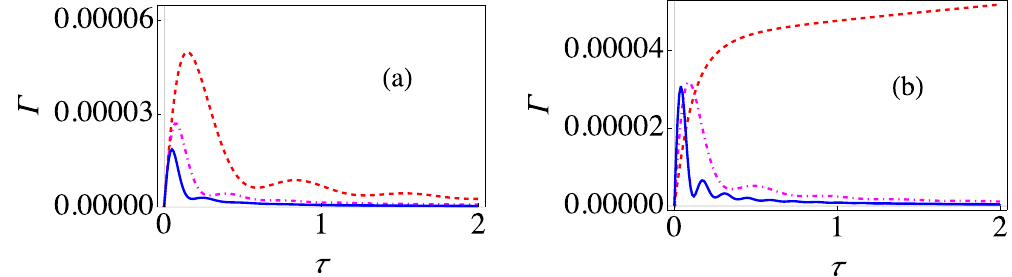
Figure 4. Variation of the decay rate Γ τ ( ) as the coupling strength and the number of two-level systems is changed. ( a ) Graph of Γ (at zero temperature) for the strong-coupling regime with j = 1 as a function of τ with the system-environment coupling strength G = 1 (red, dashed curve), G = 1.75 (dot-dashed, magenta curve), and G = 2.5 (solid, blue curve). Here we have used an Ohmic environment ( s = 1), with ε = 1 , ω = 10 , and c ∆ = . 0 05 . The initial state is | j 〉 . ( b ) Graph of Γ (at zero temperature) for the strong-coupling regime with G = 1.5 as a function of τ with = . j 0 5 (red, dashed curve), j = 1 (dot-dashed, magenta curve), and j = 2 (solid, blue curve). We have s = 1, ε = 1 , ω = 10 , and Δ = 0.05. The initial state is | j 〉 c